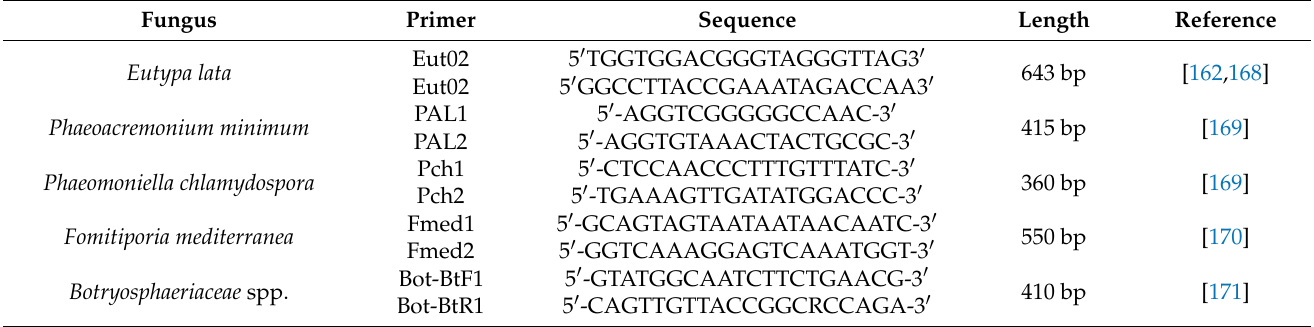
Table 1. Specific primers to detect different fungal species involved in vine wood